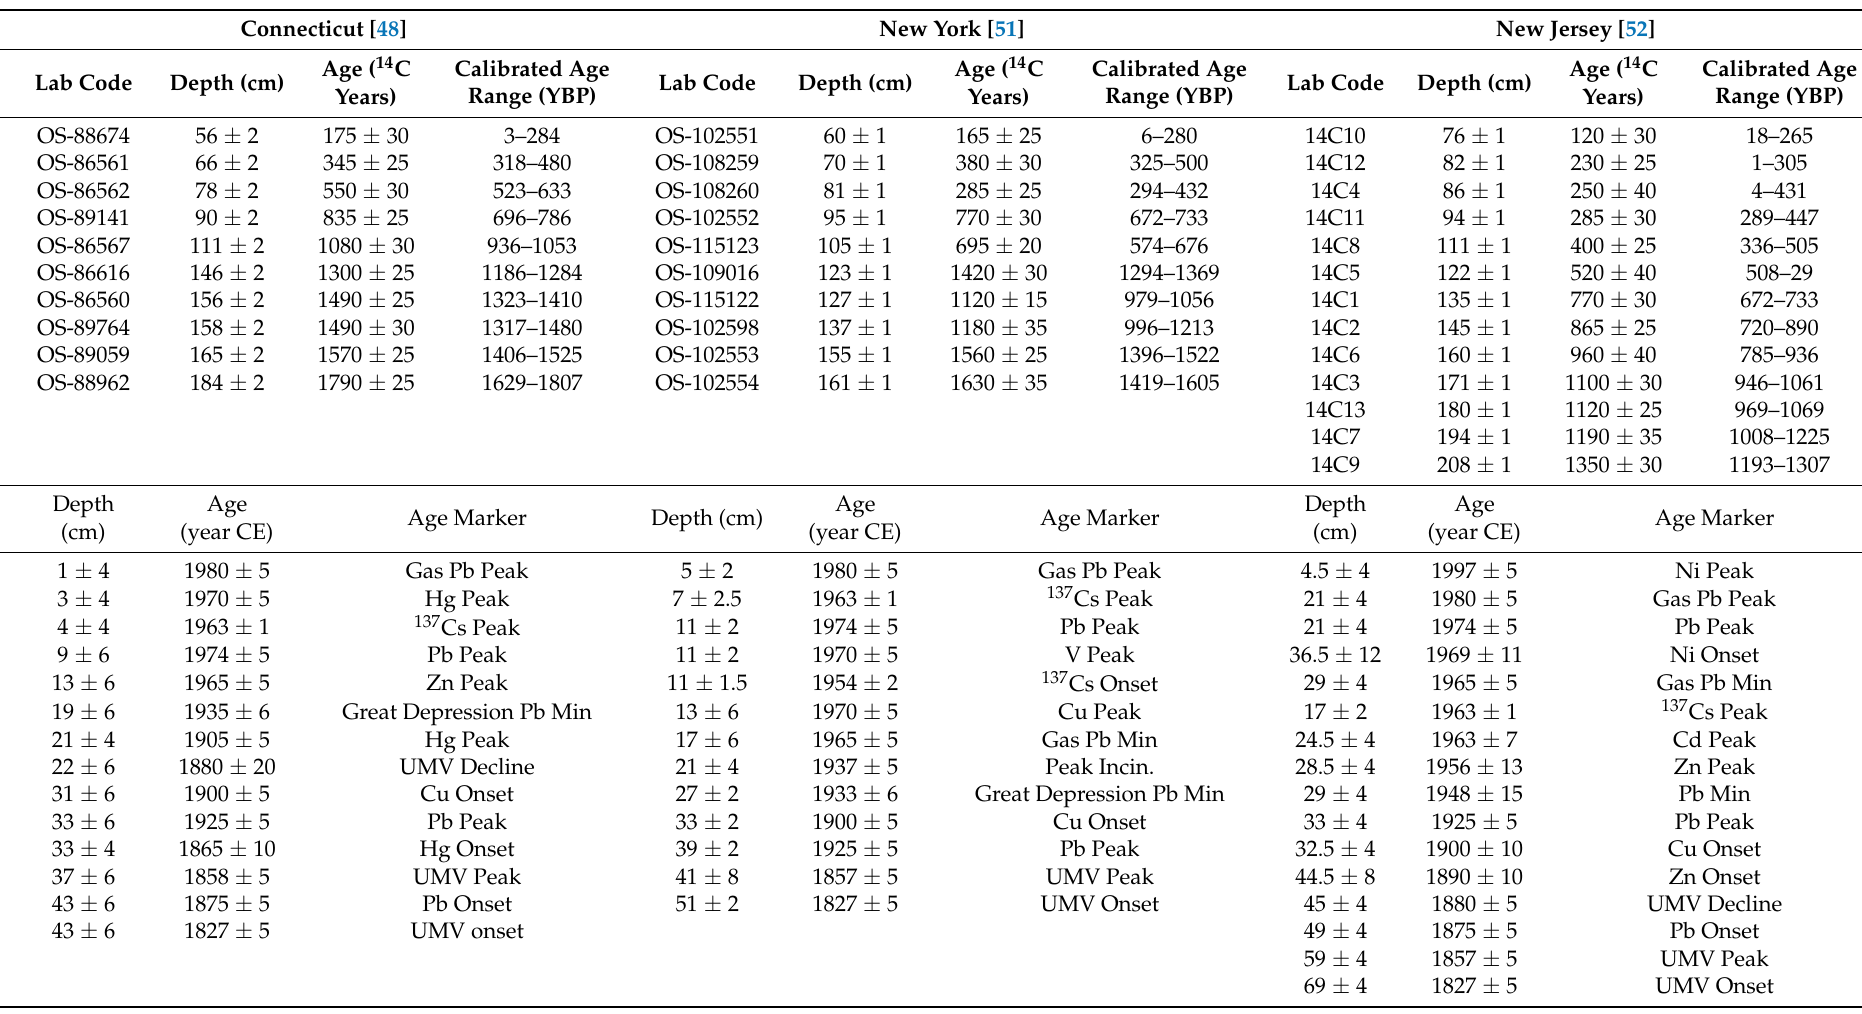
Table A1. Chronological data for published sites. UMV refers to lead (Pb) pollution originating from the Upper Mississippi Valley. YBP = years before